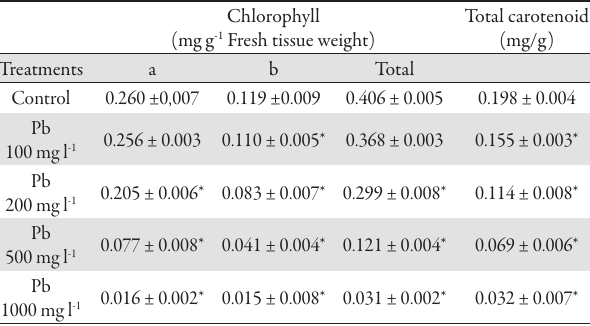
Tab. 1. Effect of lead on different pigments in radish ( Raphanus sativus ) seedlings